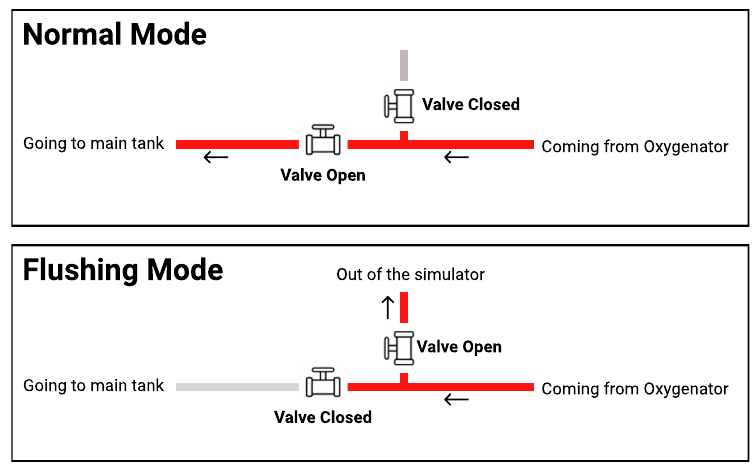
Figure 5. Path of the thermochromic loop in normal operation and in flushing mode .